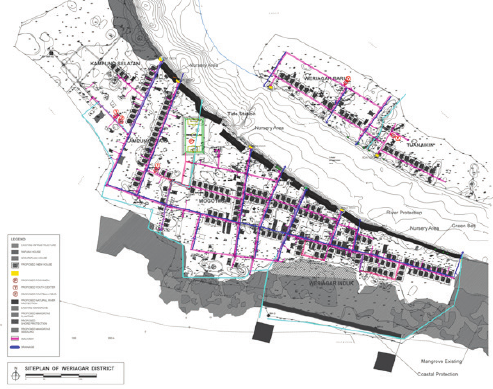
Figure 5. Arrangement pattern of public infrastructure